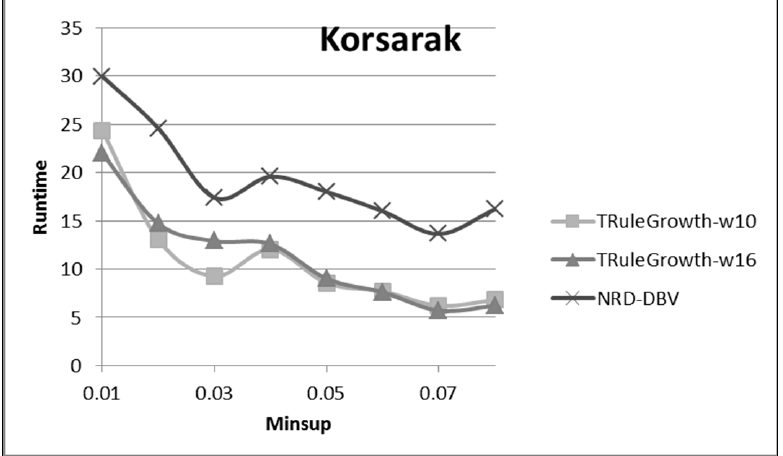
Figure 10. Comparison of the runtime of the TRuleGrowth with the NRD-DBV for (Korsarak) dataset.